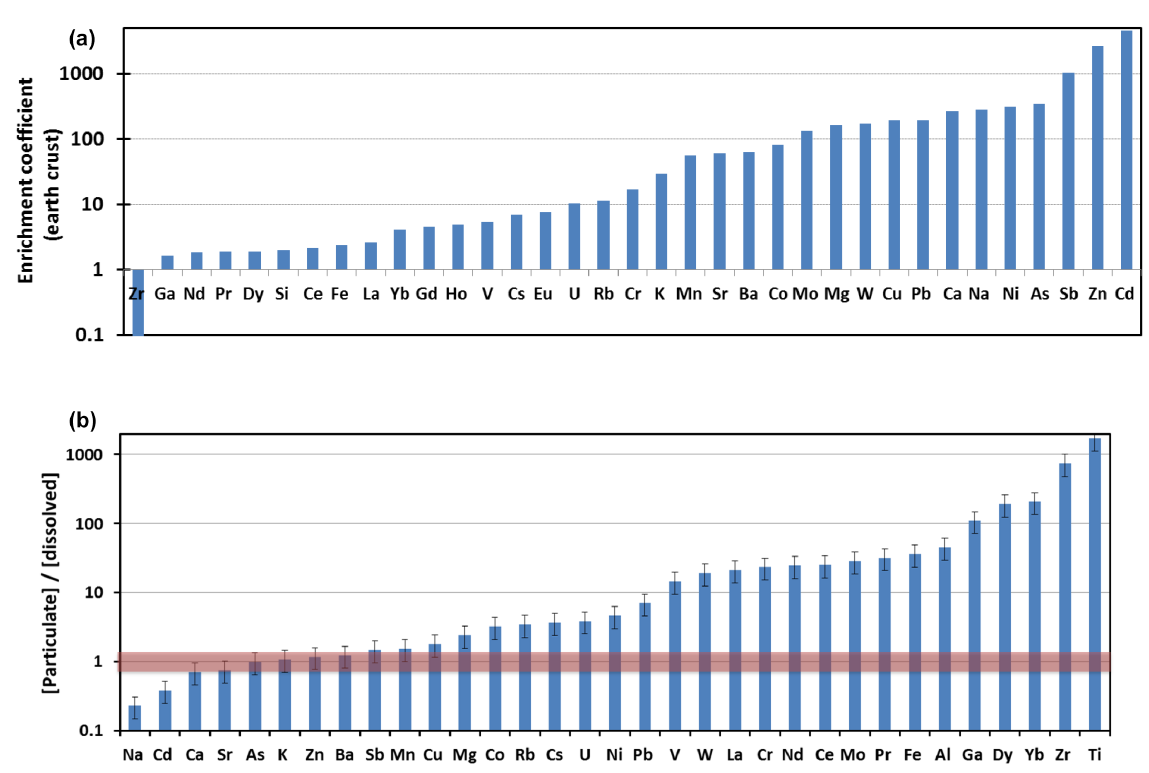
Figure 5. (a) The latitude-averaged Al-normalized enrichment coefficients of snow particles with respect to the Earth crust. (b) The average values (56 to 68 ◦ N) of the ratio of particulate to dissolved element concentration in snow water of western Siberia. The bold red line indicates statistically non-significant deviation from